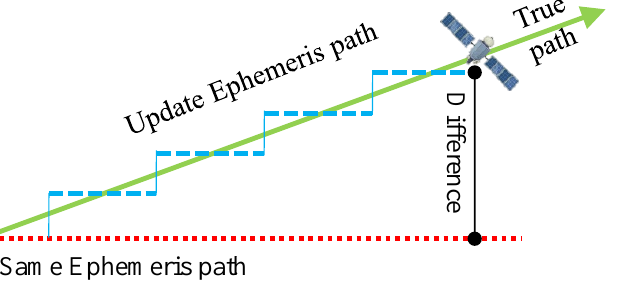
Figure 10. Schematic diagram of